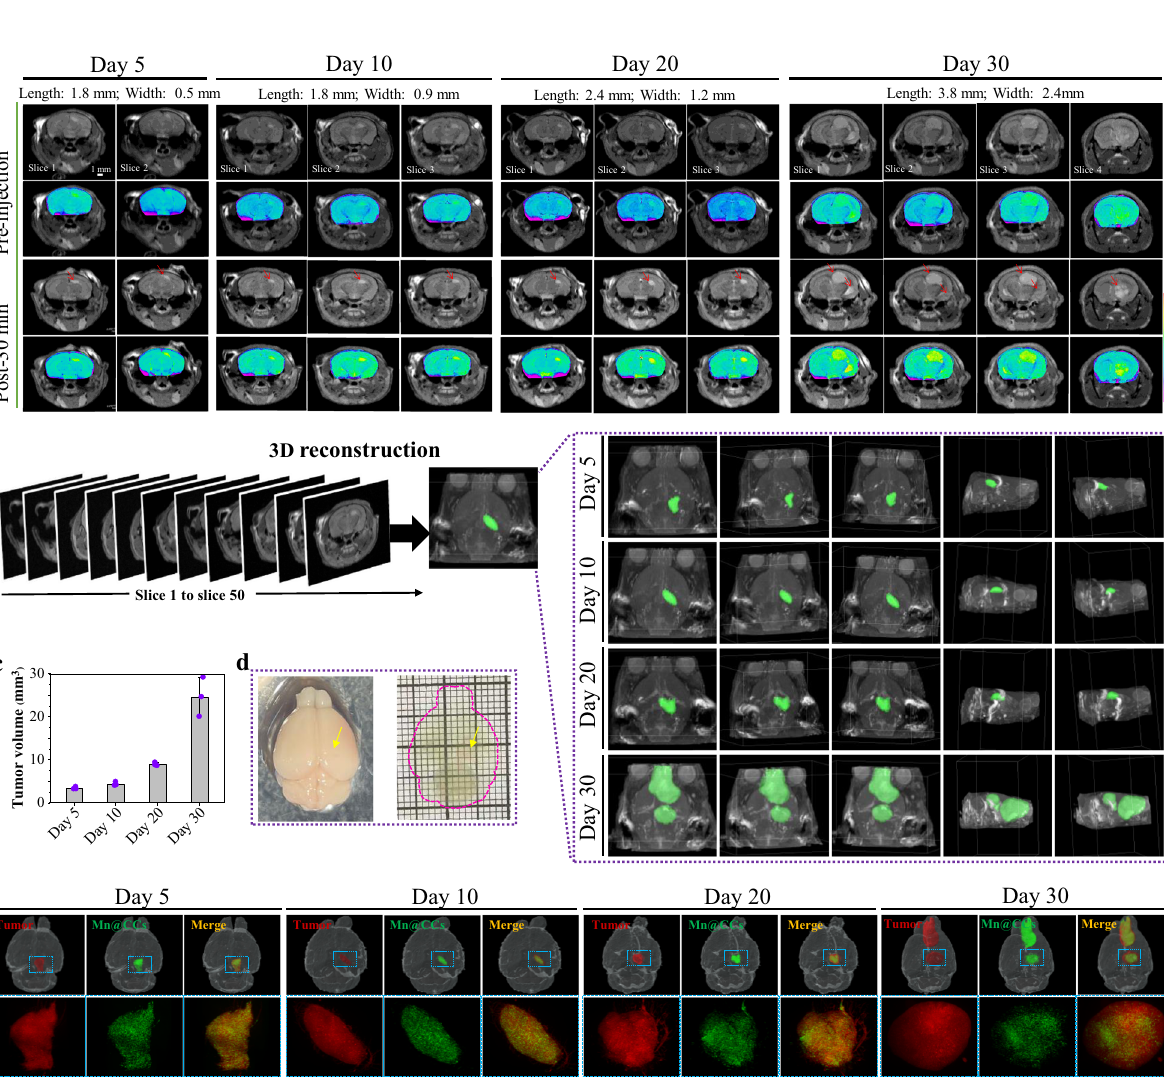
Fig. 6 Evaluation of Mn@CCs preferentially target the microscopic gliomas in an intracranial mouse model by MR imaging. a , b In vivo axial MR images of U87MG glioma-bearing mice at different timepoints after intravenous administration of Mn@CCs and Gd-DTPA. c , d Quanti fi cation of MRI signals in glioma at different timepoints of Mn@CCs ( c ) and Gd-DTPA ( d ) in a and b ( n = 3 biologically independent animals). All the statistical data are expressed as mean values± SD. Signi fi cant difference compared with control. * P < 0.05, *** P < 0.001. Statistical signi fi cance was assessed via unpaired two-tailed Student ’ s t -test. e Comparison of Mn@CCs and Gd-DTPA to image ability of microscopic glioma ( n = 3 biologically independent animals). All the statistical data are expressed as mean values ± SD. *Signi fi cant difference compared with Mn@CCs and Gd-DTPA: 30 min ( p < 0.001), 1 h ( p = 0.002), 2 h ( p = 0.008), 4 h ( p = 0.023), respectively. * P < 0.05. Statistical signi fi cance was assessed via an unpaired two-tailed t -test. f , g In vivo coronal MR images of U87MG glioma-bearing mice at different timepoints after intravenous administration of Mn@CCs and Gd-DTPA. h , i Quanti fi cation of MRI signals in glioma at different timepoints of Mn@CCs ( h ) and Gd-DTPA ( i ) in f and g ( n = 3 biologically independent animals). All the statistical data are expressed as mean values ± SD. Signi fi cant difference compared with control. * P < 0.05, *** P < 0.001. Statistical signi fi cance was assessed via unpaired two-tailed Student ’ s t -test. j Comparison of Mn@CCs and Gd-DTPA to image ability of microscopic glioma (n = 3 biologically independent animals). All the statistical data are expressed as mean values ± SD. *Signi fi cant difference compared with Mn@CCs and Gd-DTPA: 30 min ( p < 0.001), 1 h ( p < 0.001), 2 h ( p = 0.003), 4 h ( p = 0.042), respectively. * P < 0.05. Statistical signi fi cance was assessed via an unpaired two-tailed t -test. k H&E staining of glioma tissue slides from nude mice. l In vivo MR images of bladder at different timepoints. m Relative signal change of bladder at different timepoints based on MR imaging results ( n = 3 biologically independent animals). All the statistical data are expressed as mean values ± SD.